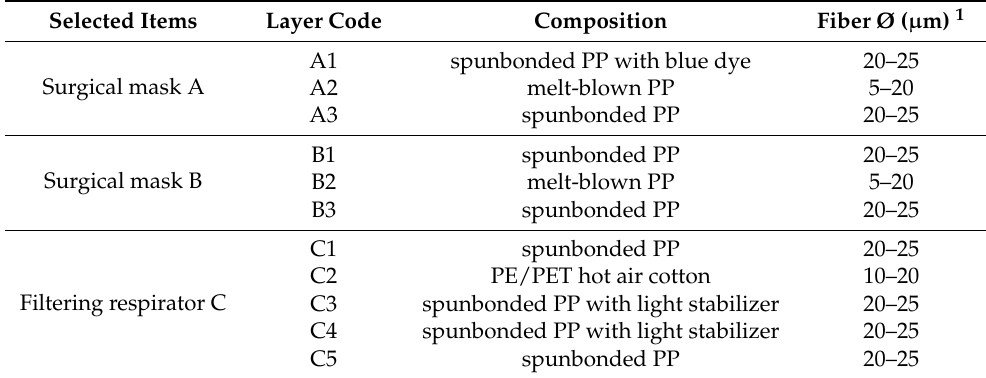
Table 1. Composition of the layers of selected face masks and respirator. Selected